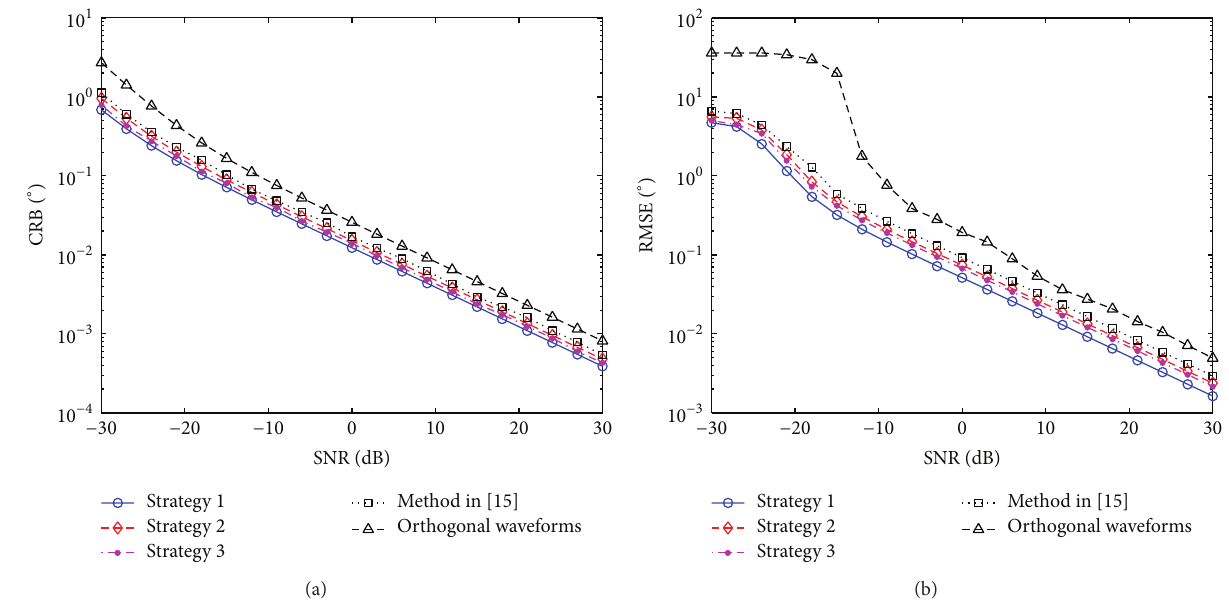
Figure 2: (a) CRB versus SNR in Example 1. (b) RMSE versus SNR in Example 1.